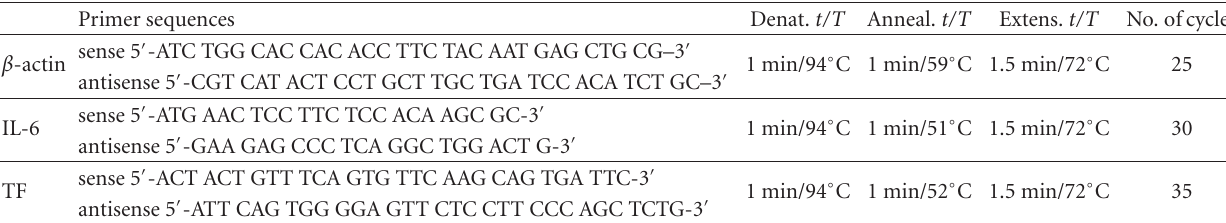
Table 1: Primer sequences and PCR